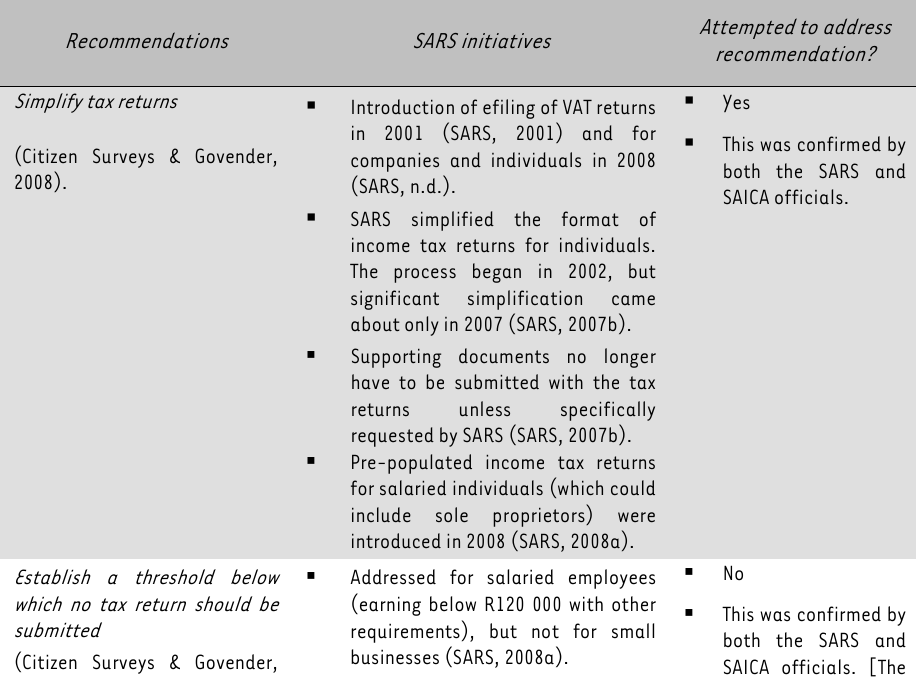
TABLE 2: A comparison of the recommendations to SARS’s initiatives